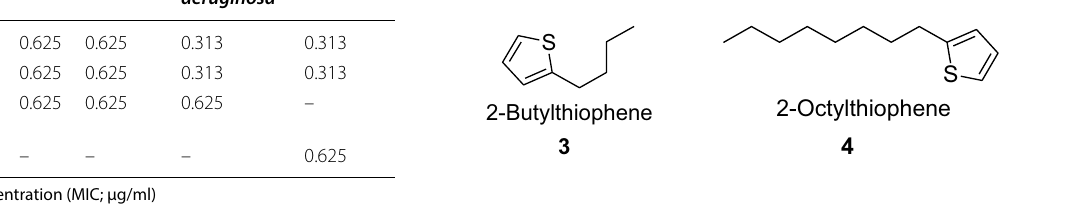
Table 2 Antimicrobial activity of thiophen-2-yl-chalcone derived heterocyclic compounds S.